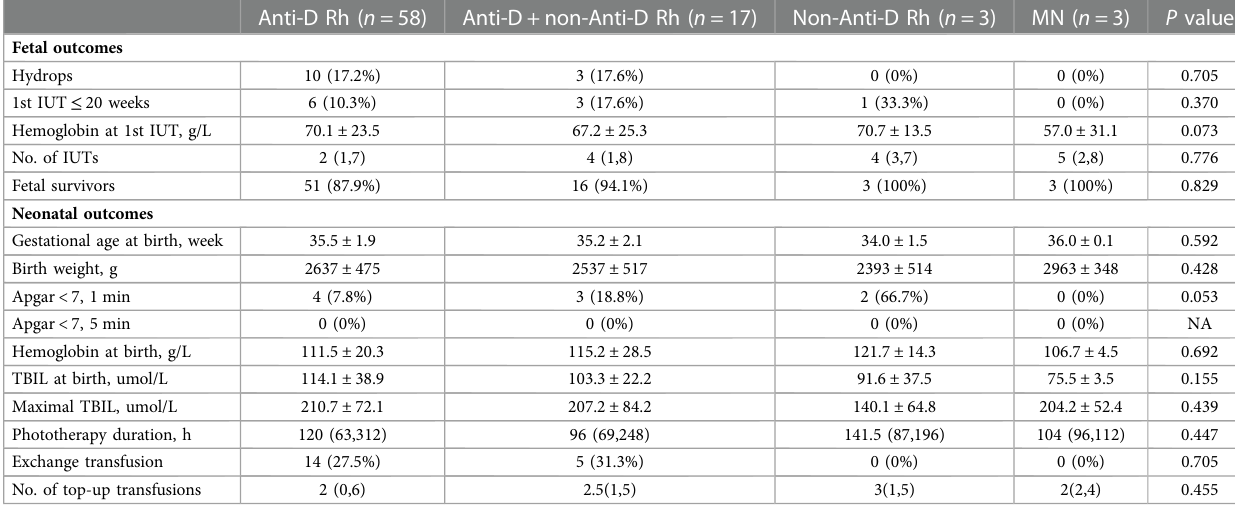
TABLE 1 Comparison of outcomes depending on the type of